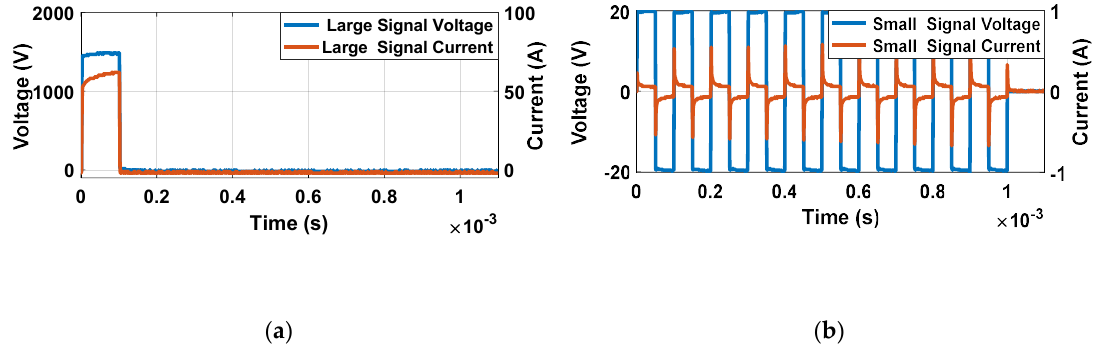
Figure 3. Large- and small-signal voltage (blue) and current (red) pulses: ( a ) large-signal pulses and ( b ) small-signal pulses.